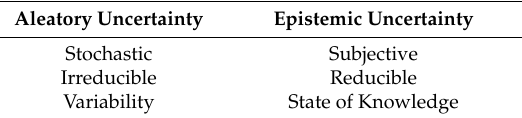
Table 1. Key differences between aleatory uncertainty and epistemic uncertainty (adapted from Benke et al.